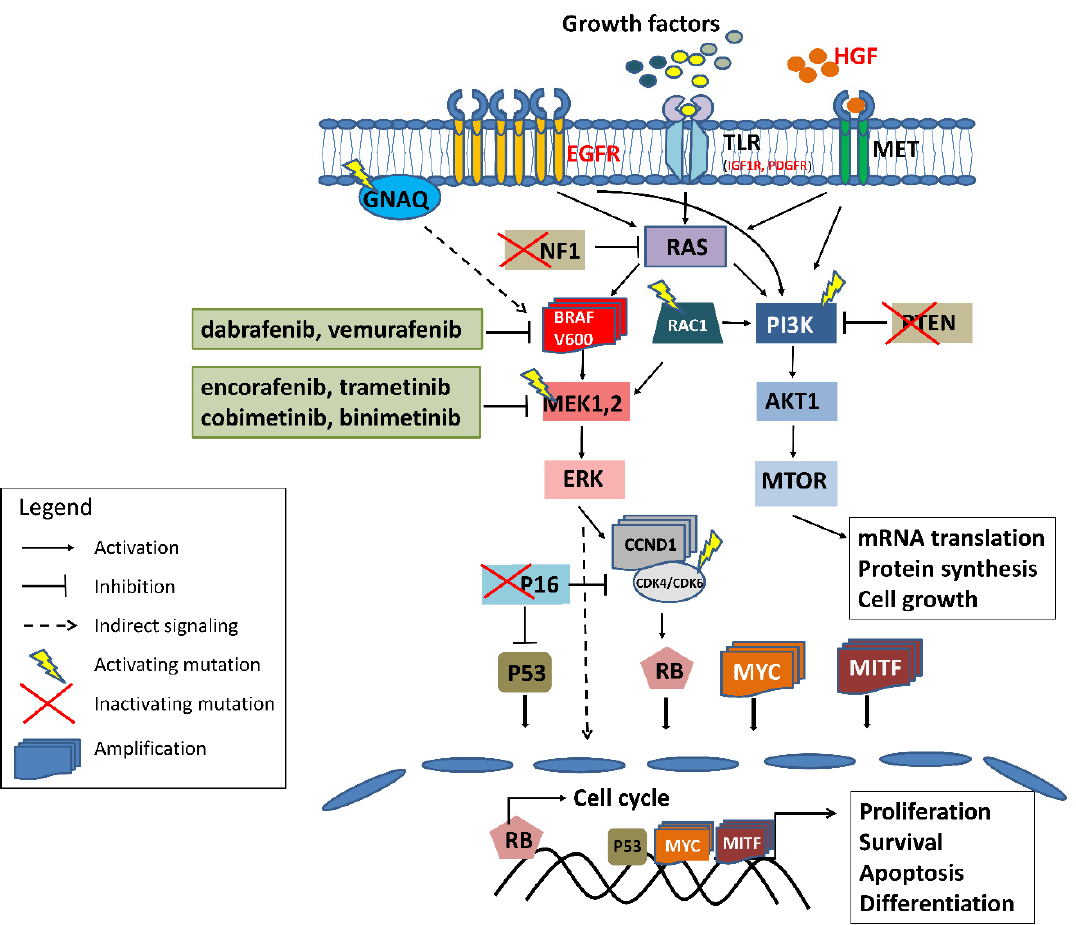
Figure 1. The scheme of the most common and well-established genetic and molecular mechanisms of melanoma resistance to BRAF/MEK inhibitors. Red font denotes overexpression of the protein; in green frames are the inhibitors registered for advanced skin melanoma treatment. For more detailed information refer to the text.